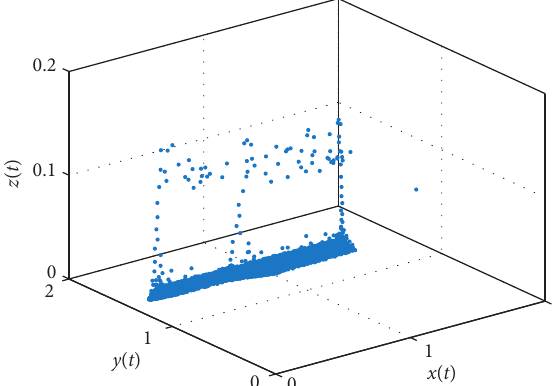
Figure 9: Strange attractors for α